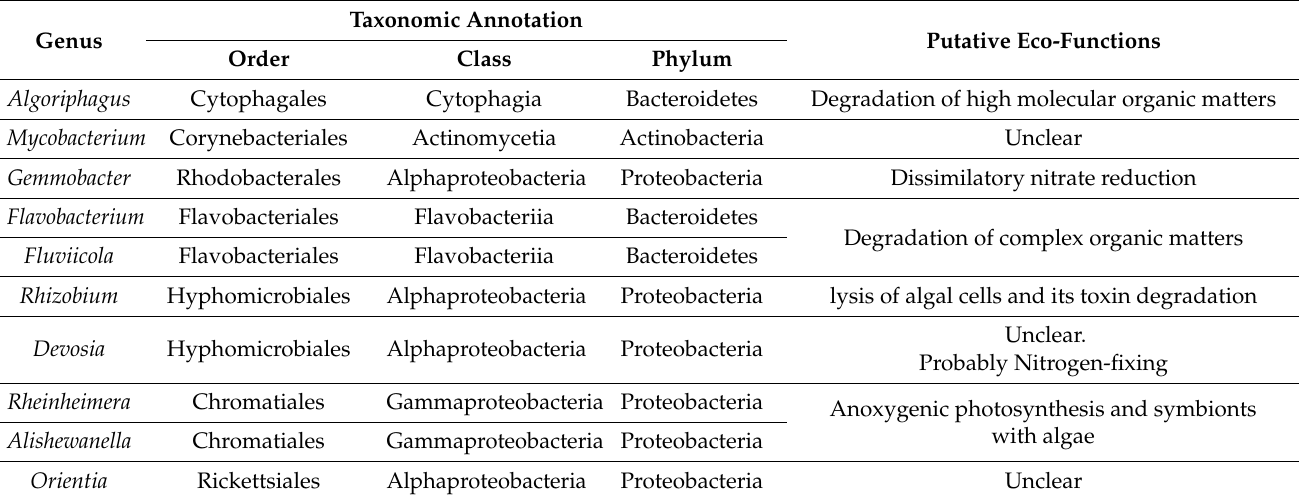
Table 3. The taxonomic and putative functions of the bacteria associated with